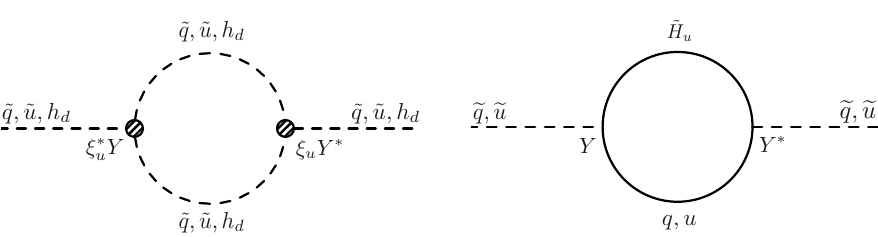
Figure 1 . Non standard soft supersymmetry breaking terms contributing to the running of the scalar